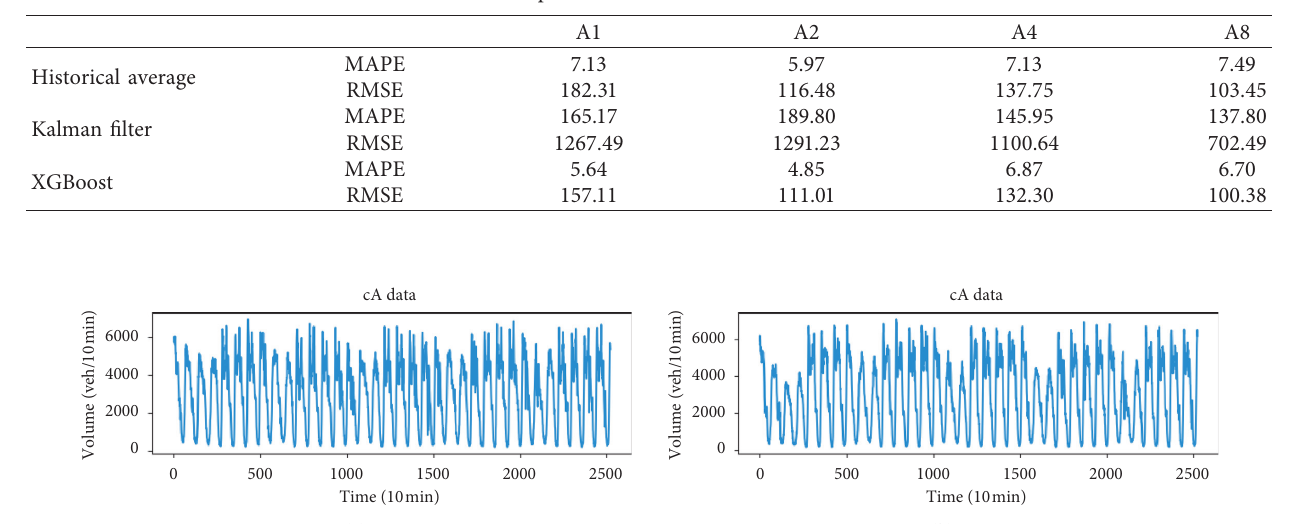
Table 2: Comparison with the conventional models.